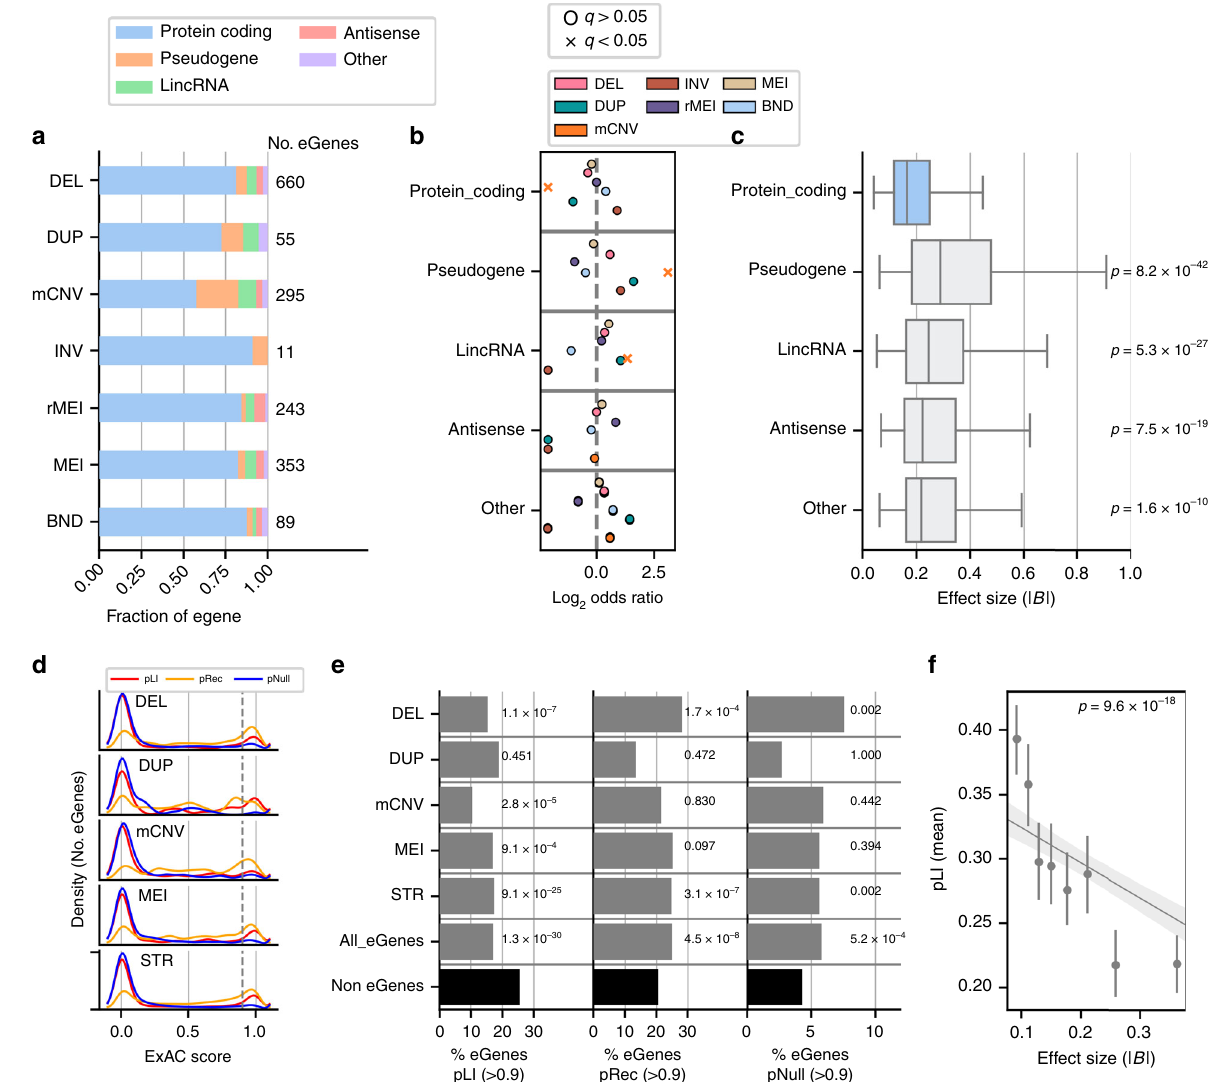
Fig. 4 Properties of eGenes associated with different variant classes. a Fraction of eGenes of each Gencode gene subtype mapped to lead variants of each class for the SV/STR-only eQTL. b Enrichment of the proportion of eGenes of each subtype mapped to a variant class compared with the proportion of other eGenes falling into that subtype. Signi fi cant associations (FET, BH FDR < 0.05) are indicated with x symbols. c Absolute effect size of associations for genes of each subtype among lead eQTLs. P values indicate signi fi cance of Mann – Whitney U test (one-sided) for difference in the effect size distributions of each category compared to protein coding genes (Bonferroni). For boxplots the minimum box edge indicates the fi rst quartile while the maximum box edge indicates the third quartile and the center line indicates the median value. Whiskers of the box plot are drawn at the maximum point (upper whisker) or minimum point (lower whisker) that is within 1.5 times the interquartile range (quartile three — quartile one). d Distribution of ExAC scores for intolerance to loss-of-function variants in a single allele (pLI, red), intolerance to loss-of-function variants in both alleles (pRec, orange), and tolerance to loss-of-function variants in both alleles (pNull, blue) for 5,675 eGenes. e The percentage of eGenes (grey bars) mapped to lead variants that had high (>0.9) pLI (left), pRec (center), or pNull scores (right). Black bars show percentages for 7,337 non-eGenes from the SV/STR-only analysis. P values indicate the signi fi cance of the difference between the proportion of high score eGenes and high score non-eGenes for each group individually (FET, BH FDR < 0.05, within each probability score). f Absolute effect size versus pLI score for all eGenes with a pLI score ( n = 5,675). Points are equally-sized bins and error bars show 95% con fi dence intervals ( n = 1000 bootstraps) around the mean pLI. Line is a model predicting pLI by eQTL effect size after regressing out variant class and mean log 10 (TPM) expression level of the gene among expressed samples. p value is for the eQTL effect size term ( t